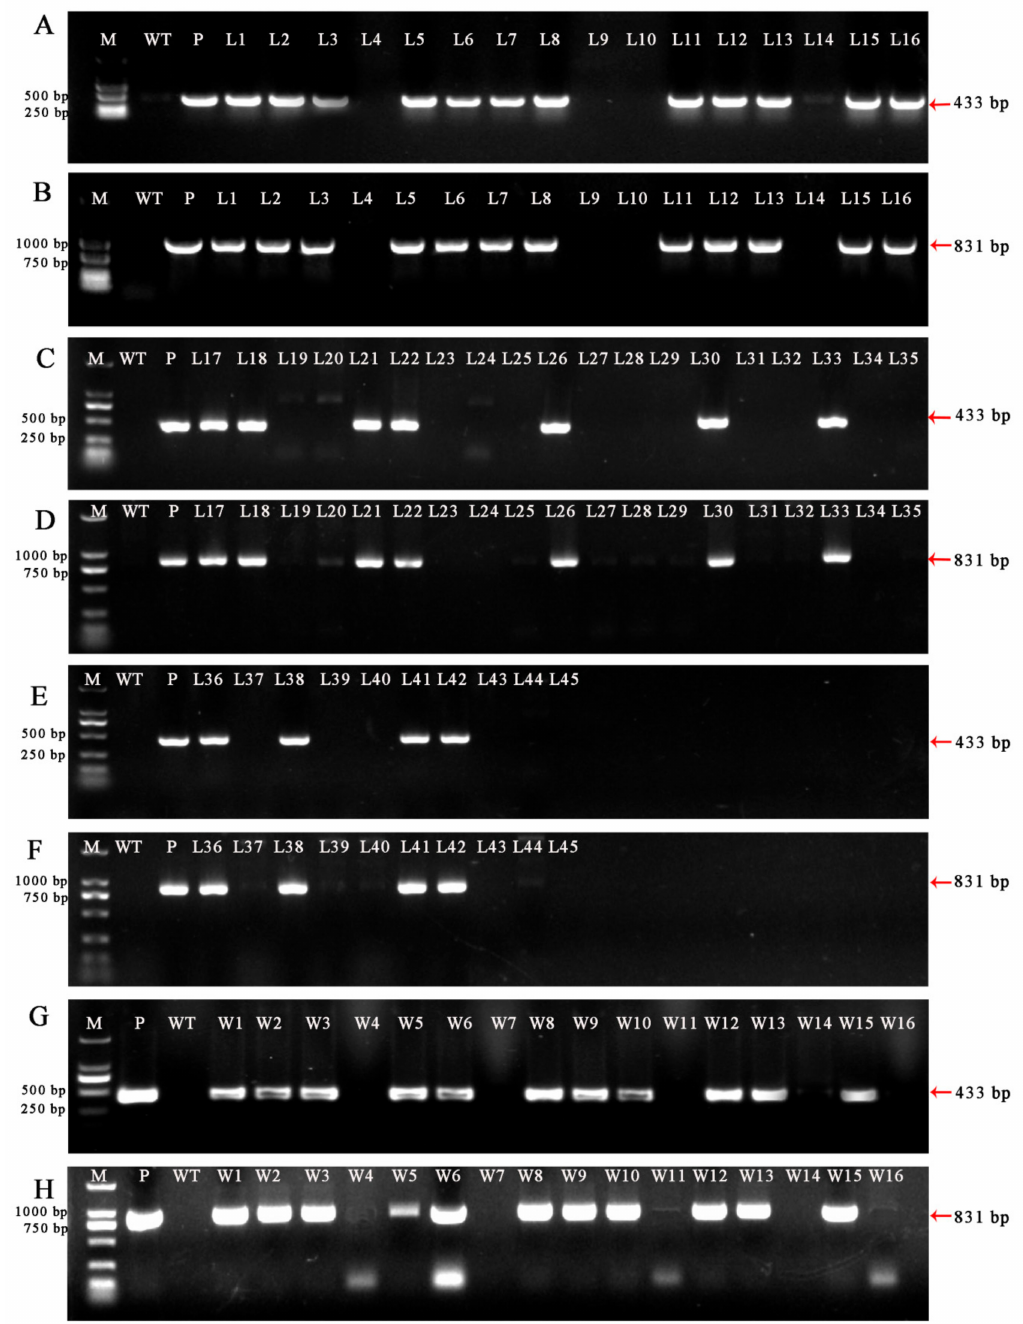
Figure 6. PCR analysis of plants with obvious albino phenotypes using the Bar gene and vector-specific primers. A , C and E PCR results for the Bar gene (433 bp) of Lilium pumilum DC. Fisch. G Bar gene (433 bp) of ‘White Heaven’. B , D and F PCR fragment of a partial sgRNA expression cassette (831 bp) of Lilium pumilum DC. Fisch. H PCR fragment of partial sgRNA expression cassette (831 bp) of ‘White Heaven’. Lane M, DL2000 DNA marker. lane WT, wild-type plant. lane P , plasmid control. A – F : Lanes 1–45, obvious albino phenotypes plants of Lilium pumilum DC. Fisch. G and H : Lanes W1–16, obvious albino phenotypes plants of ‘White Heaven’, Only 16 lines are shown, and others no band was